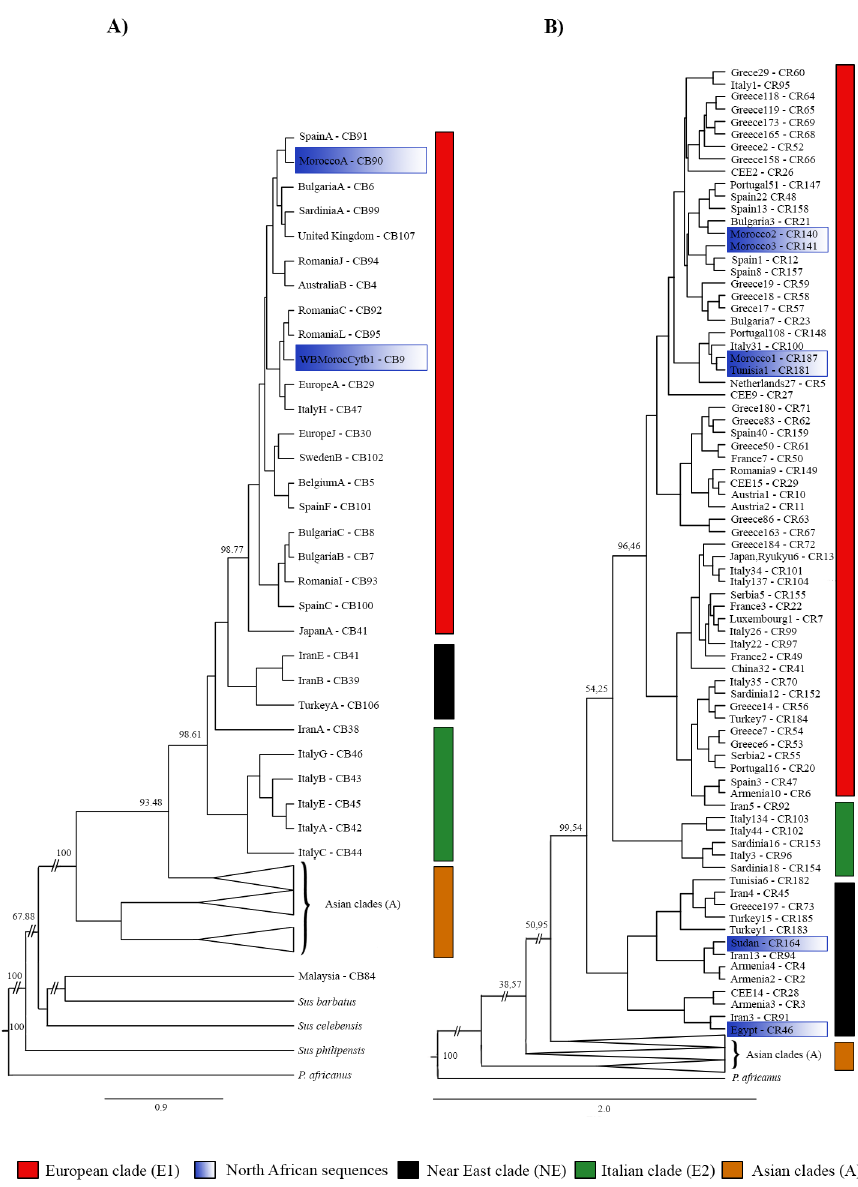
Fig 1. Bayesianphylogenetic trees based on mtDNA. (A) The cytochrome b phylogenetictree was constructed with 111 haplotypes (897 bp), which represent 363 wild boars and four outgroups. (B) The control regionphylogenetic tree was constructed with 188 haplotypes (415 bp), which represented 1,215 wild boars and two outgroups. CEE is the abbreviationfor Centraland Eastern Europe. In both cases, the numbers abovebranches indicateposterior values as a percentage (%). Names of sequencescorrespondto those of the sequencesused to represent each haplotype. The haplotypecode assignedin this work has been added.